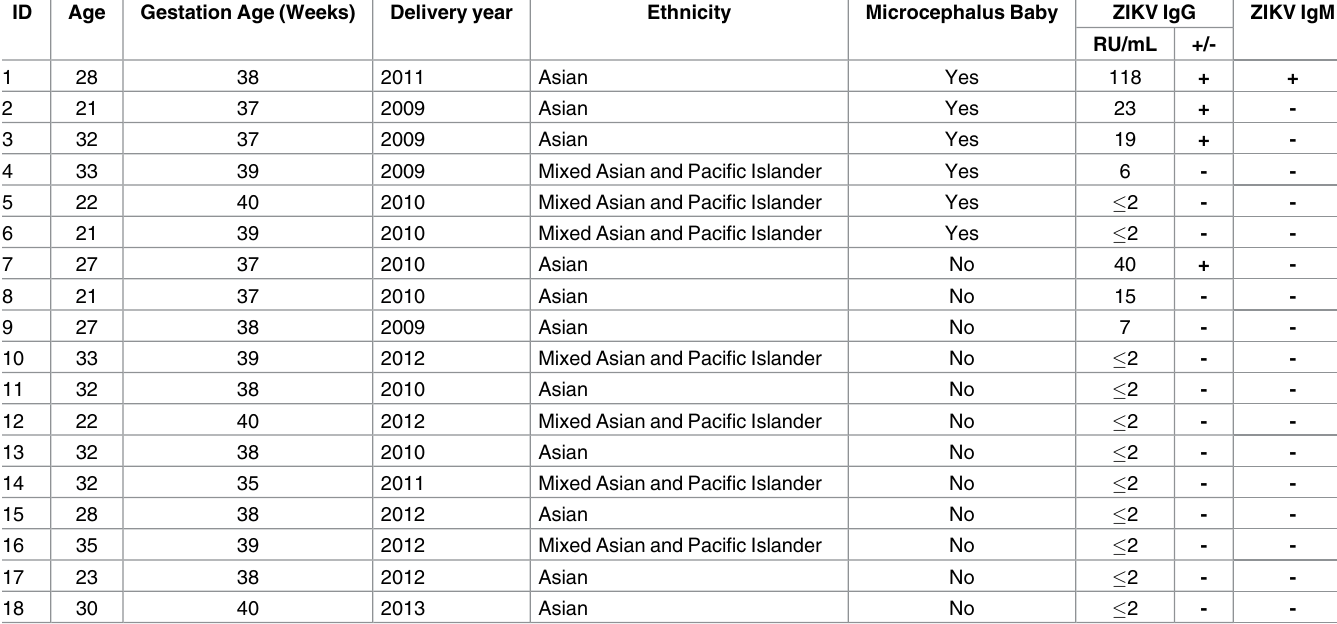
Table 1. Clinical and epidemiological characteristics of mothers who gave birth in Hawaii